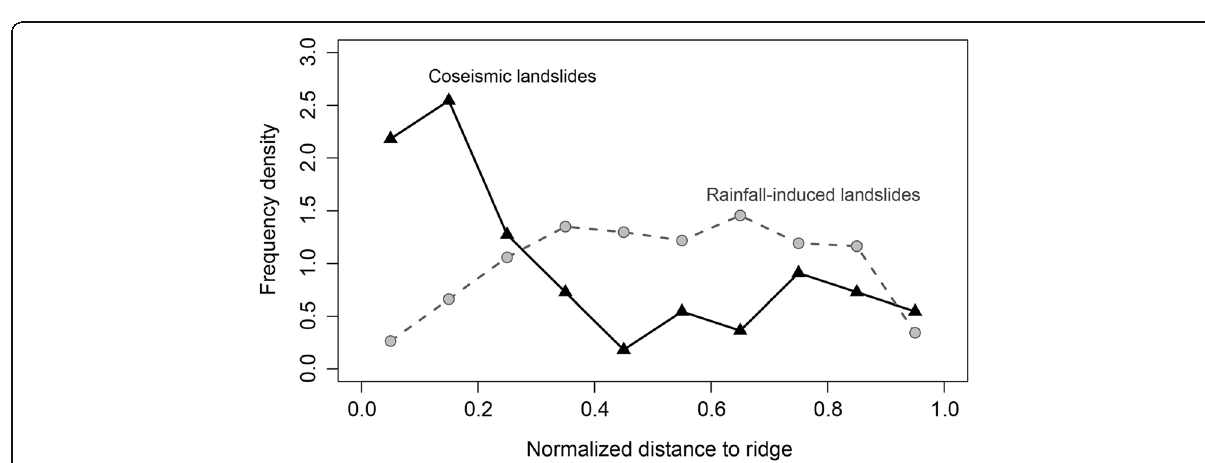
Fig. 7 Frequency density distributions of normalized distances to ridges from coseismic (black line) and rainfall-induced (gray dashed line) landslides. Normalized distances to ridges vary from 0 for a cell located on the ridge to 1 for a stream